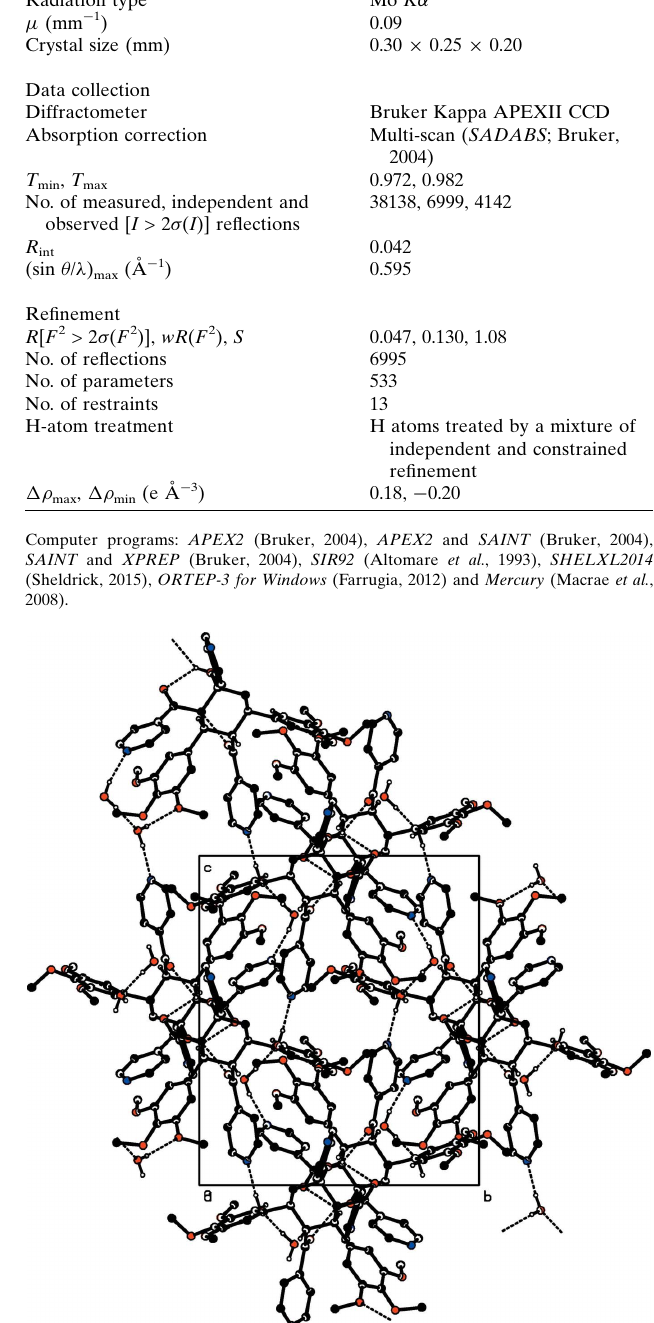
Figure 2 Linking of the molecules and water molecules by hydrogen bonds (dashed lines).